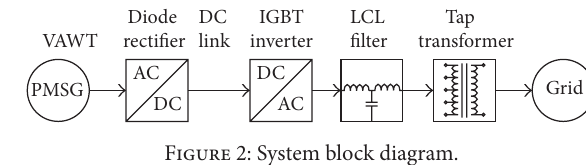
Figure 2: System block